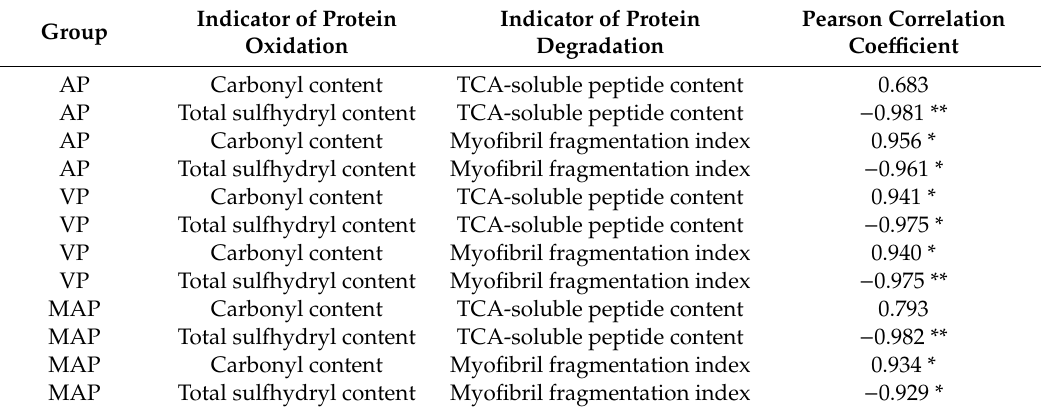
Table 2. Correlation analysis between protein oxidation and the degradation of grouper in three groups. Indicator of Protein Indicator of Protein Pearson Group